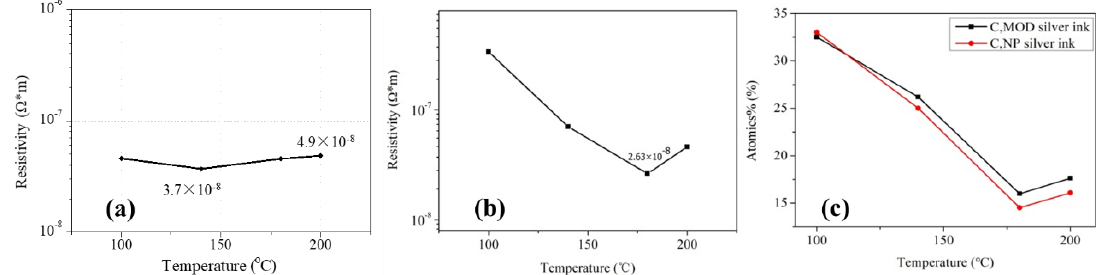
Figure 1. Electrical resistivity and relative carbon content of silver film at different heat-cured temperatures: ( a ) Silver films based on the nanoparticles (NP) ink were heat cured for 30 min; ( b ) silver films based on the metal-organic decomposition (MOD) ink were heat cured for 10 min; ( c ) relative carbon content of heat-cured silver films.